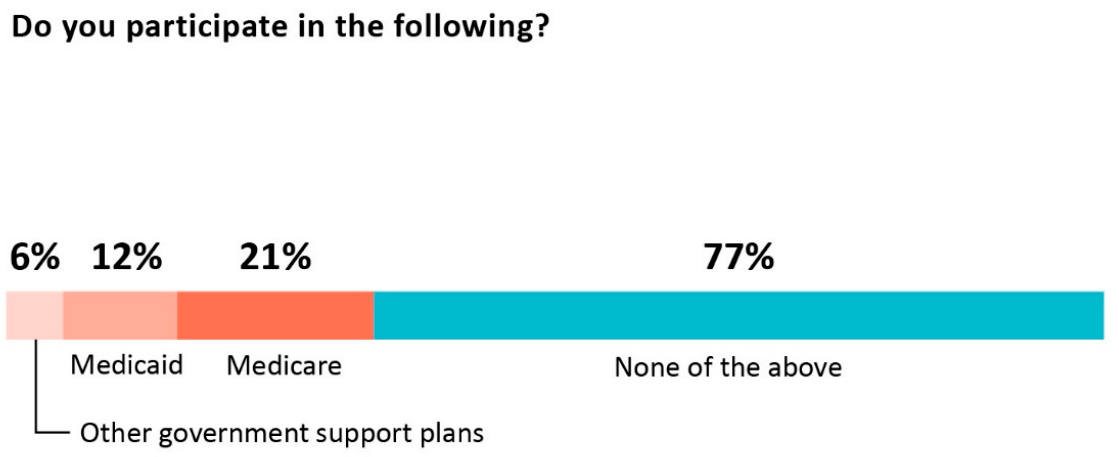
Figure 3. Participation in government supported health plans .